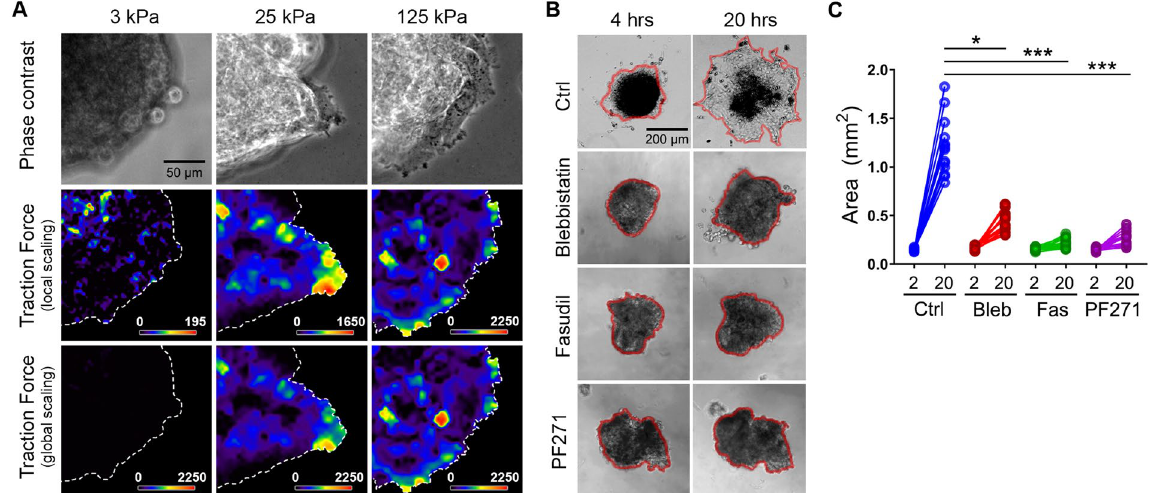
Figure 9. A mechanotransduction pathway comprising ROCK, actomyosin contractility, and FAK controls disaggregation of ovarian cancer spheroids. ( A ) Traction forces underlying SKOV3 ovarian cancer spheroids at 2 h after plating on FN-coated hydrogels with rigidities of 3 kPa, 25 kPa, or 125 kPa, as indicated. Phase contrast images (top), calculated traction forces with local scaling (middle), and calculated traction forces with global scaling (bottom) are shown for representative spheroids on each hydrogel rigidity. ( B ) Phase contrast images of SKOV3 ovarian cancer spheroids, treated 2 h after plating with 0.1% DMSO (Ctrl), 25 µ M blebbistatin, 10 µ M fasudil, and 0.25 µ M PF271, were captured at 4 h and 20 h post plating on hydrogels with rigidity of 25 kPa. Red lines help visualize the boundaries of the tumor spheroids at each timepoint. ( C ) Quantification of changes in area between 2 hours and 20 hours of DMSO control-, blebbistatin-, fasudil-, and PF271-treated spheroids (n = 16 spheroids for each treatment; * p = 0.0286; *** p <